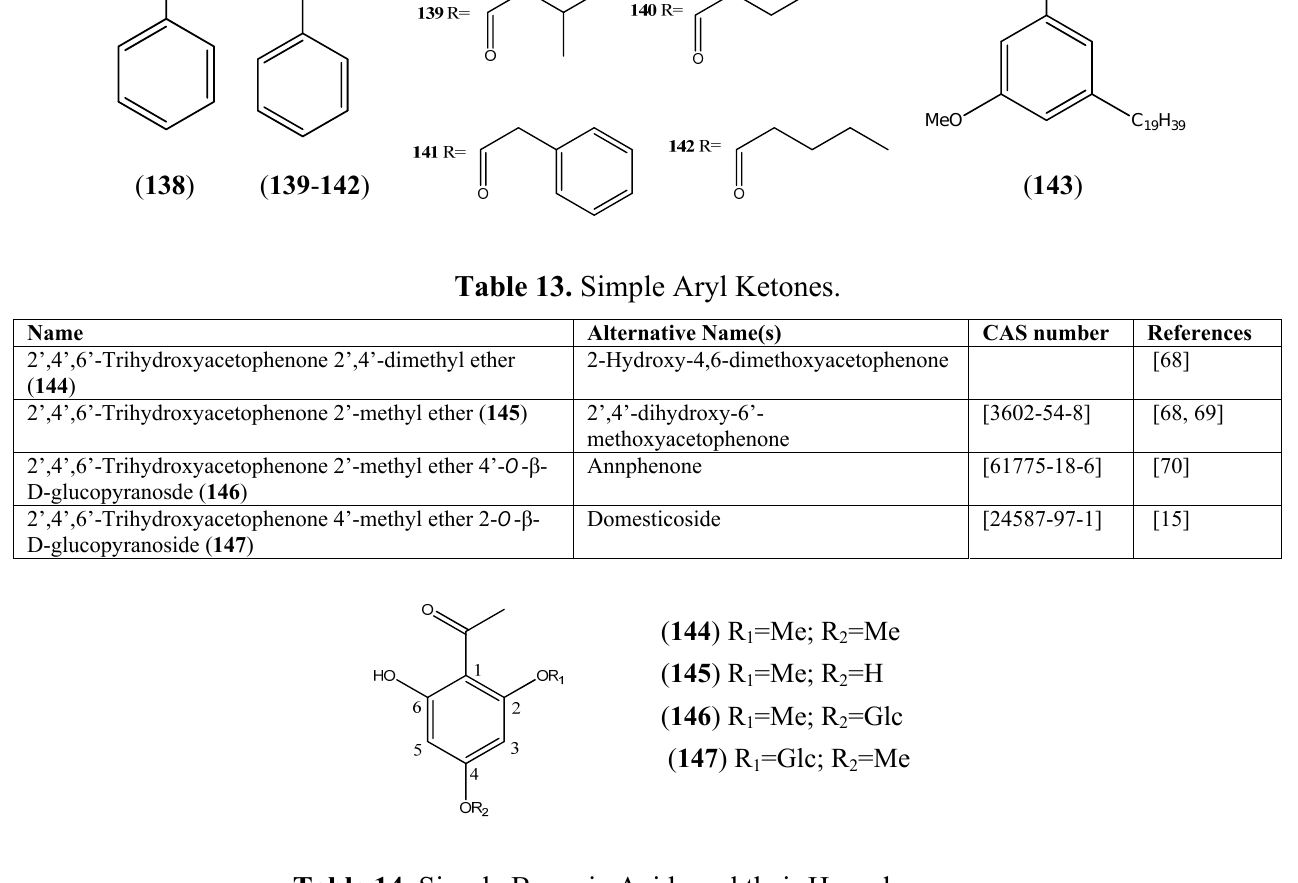
Table 14. Simple Benzoic Acids and their